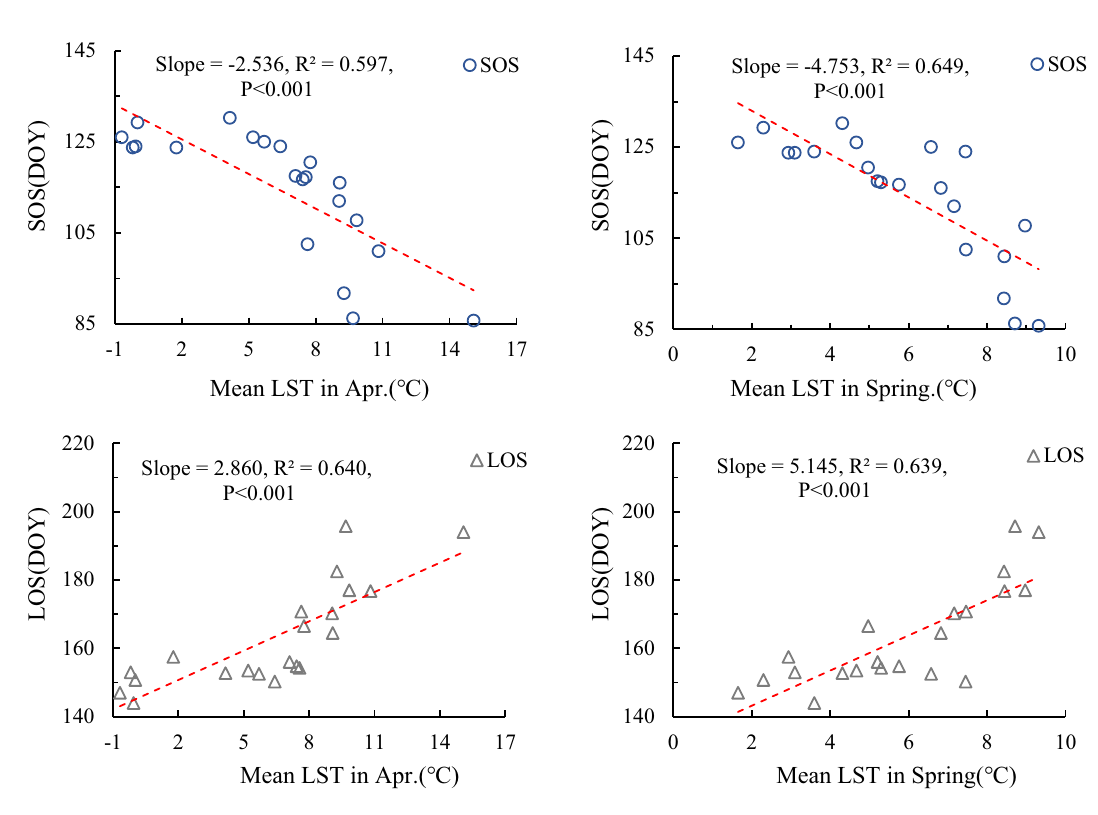
Figure 7. Regression analysis of temperature and phenological